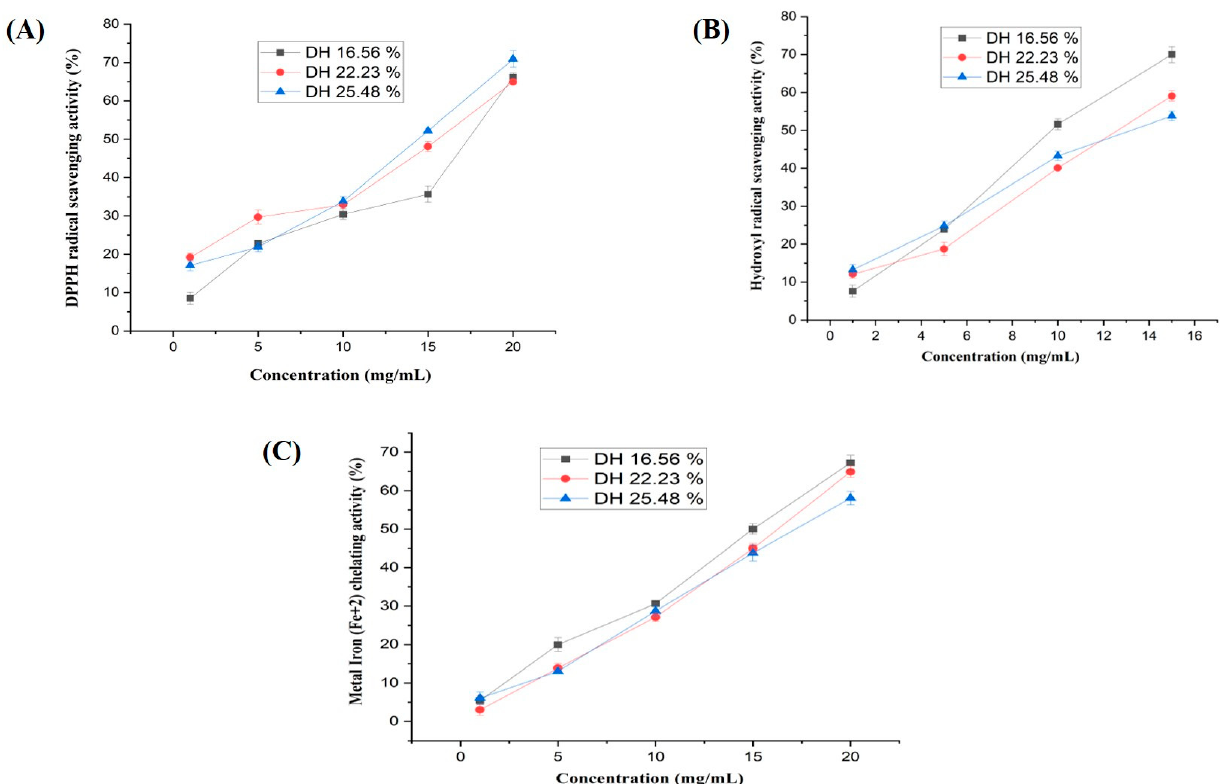
Figure 7. Antioxidant assays of FPH produced under optimal parameters at different degrees of hydrolysis, ( A ) DPPH radical ‐ scavenging activity, ( B ) hydroxyl radical ‐ scavenging assay, and ( C ) of hydrolysis, ( A ) DPPH radical-scavenging activity, ( B ) hydroxyl radical-scavenging assay, and Fe +2 ‐ chelating activity. The results are displayed as mean ± SD with triplicates. ( C ) Fe +2 -chelating activity. The results are displayed as mean ± SD with